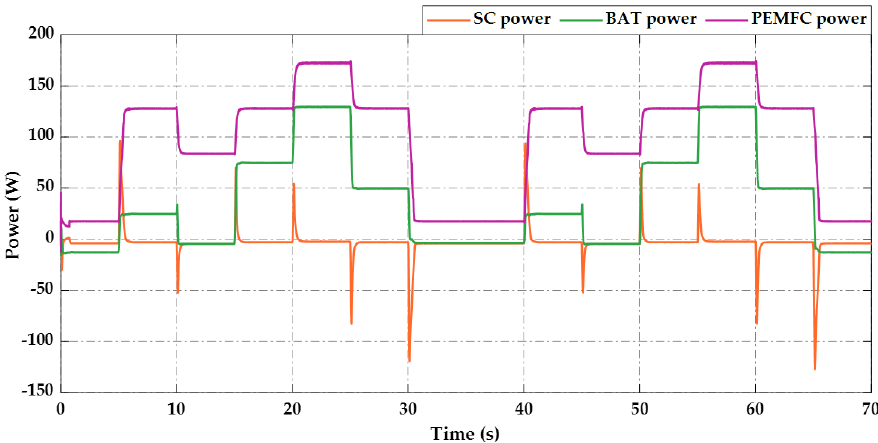
Figure 19. The power distribution from energy sources.